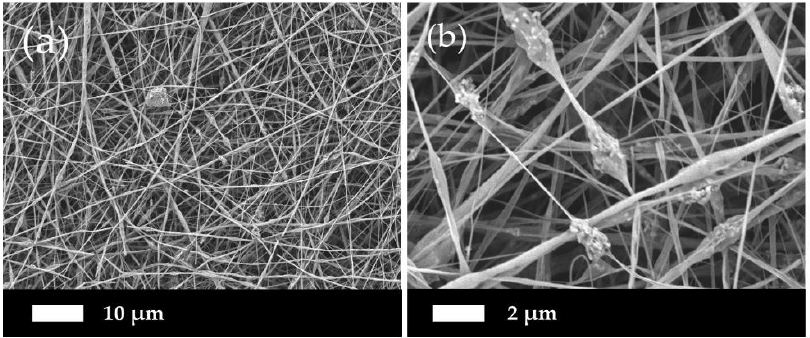
Figure 5. Higher content of β -TCP (6%) particles damaging the structure of nanofibers at magnification of ( a ) 1000× and ( b ) 5000×.